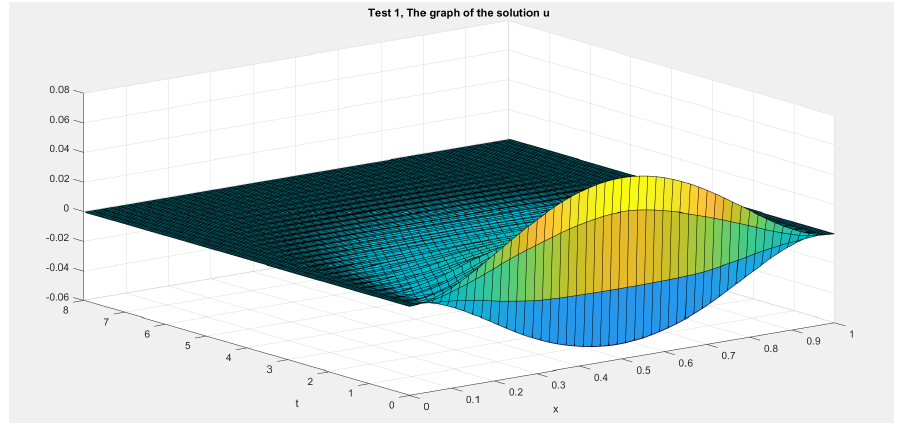
Figure 8. Test4: The energy decay.